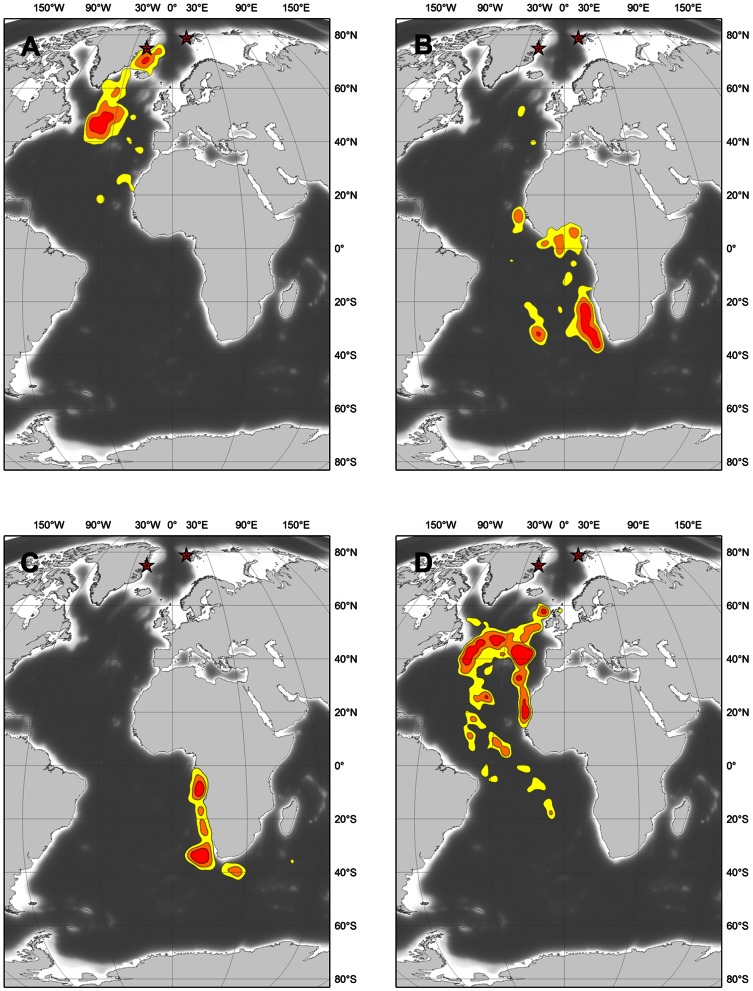
Kernel density distribution estimated for the Long-tailed Skuas.(a) from release to September 10th, (b) between October 10th and November 31st, (c) December and January and (d) after April 10th. Contours represent densities of 25% (red), 50% (orange) and 75% (yellow).